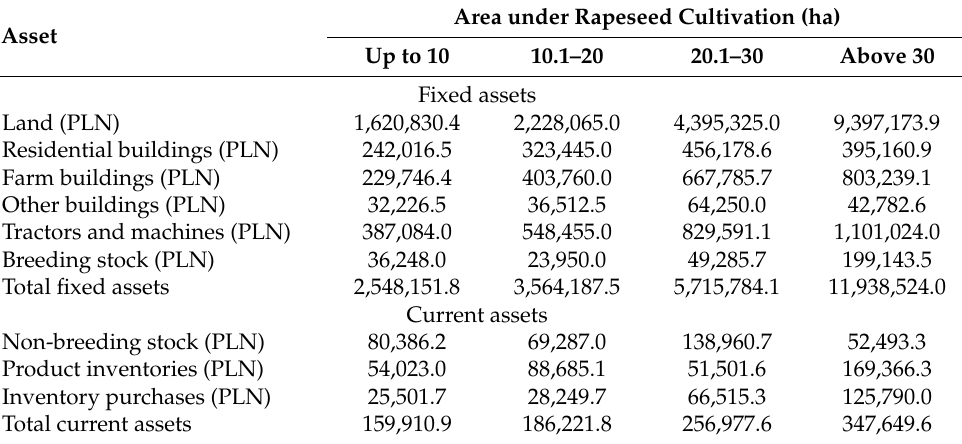
Table 2. Values of fixed and current assets vs. area under rapeseed cultivation for the analyzed farms.